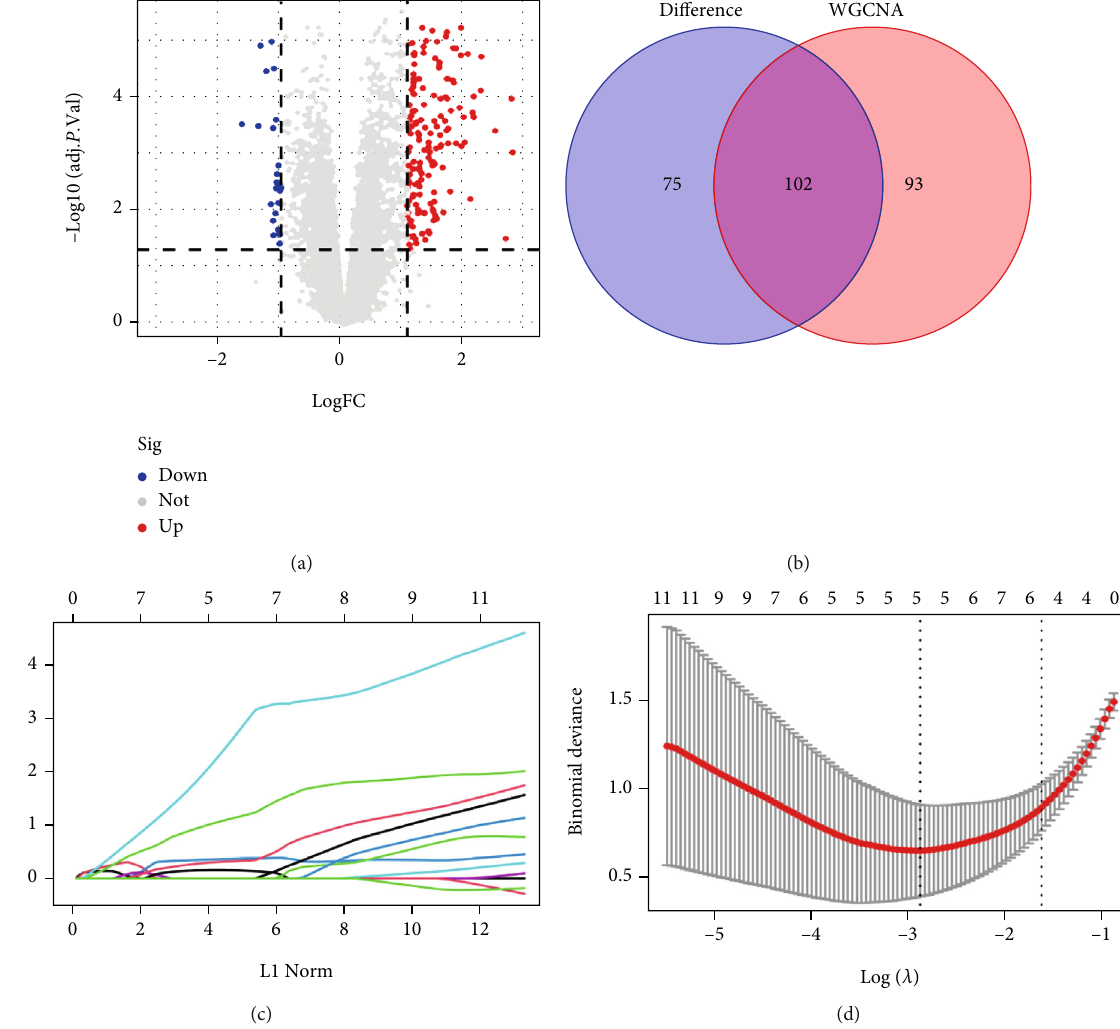
Figure 3: Identifying the DEGs and the sreening of hub genes. (a) Volcano plots for the DEGs in the early and advanced carotid atherosclerotic plaques. (b) Venn diagram indicating the intersection between the brown module and DEGs. (c) Partial likelihood deviance having a changing of log ( λ ) that was plotted using the LASSO regression in the 10-fold cross-validation. The dotted vertical lines were plotted using the minimal criteria (lambda.min) and 1-SE of minimal criteria (1-SE criteria) at the optimal values. (d) LASSO coe ffi cient pro fi les of the 5 hub genes using 10-fold cross-validation. DEGs: Di ff erentially Expressed Genes. LASSO: Least Absolute Shrinkage and Selection